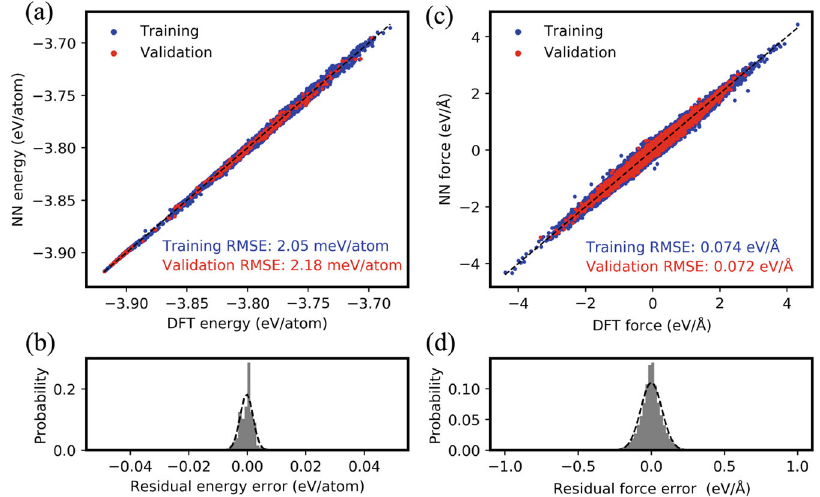
Fig. 1 Accuracy of the GeTe NN potential. Correlation of the NN potential predicted ( a ) energies and ( c ) atomic forces with the corresponding reference DFT results for all structures in our training and validation sets. Distribution of the NN potential residual errors for ( b ) energies and ( d ) atomic forces in the validation set. A normal distribution fi tted to the validation set errors is shown as a black dashed